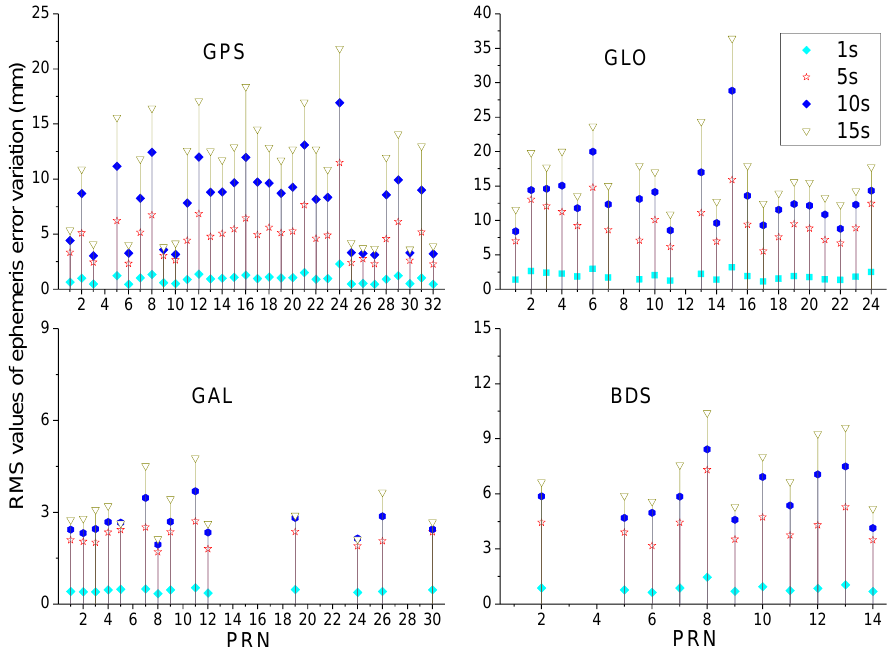
Figure 8. RMS result for 1, 5, 10, and 15 s latency variation of broadcast ephemeris error on 10 January 2018.